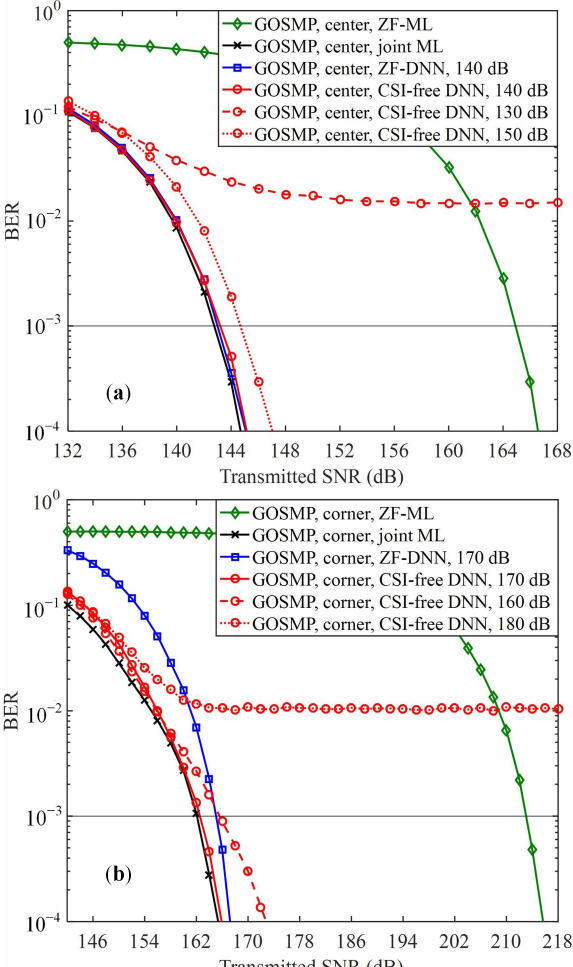
Figure 5. BER comparison of the proposed CSI-free DNN detector and three benchmark detectors for GOSMP at ( a ) the center and ( b ) the